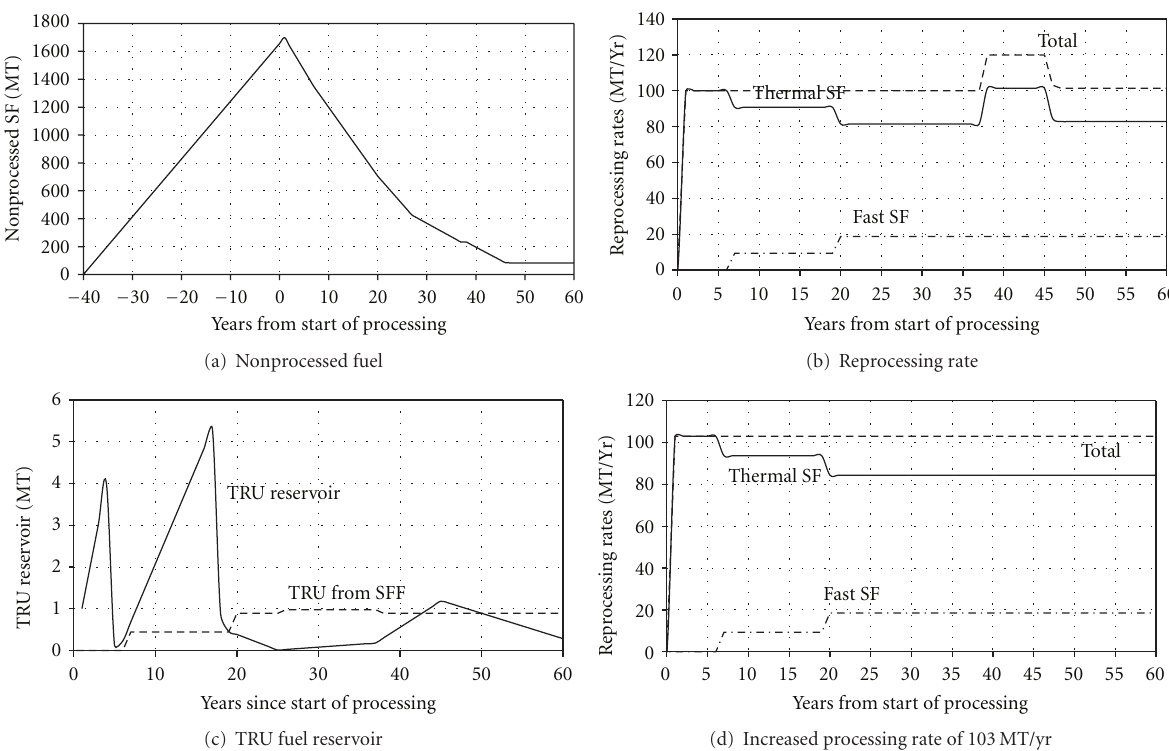
Figure 5: Conversion to four thermal, two fast spectrum plants (BR = 0.5, increased to 0.55 and then